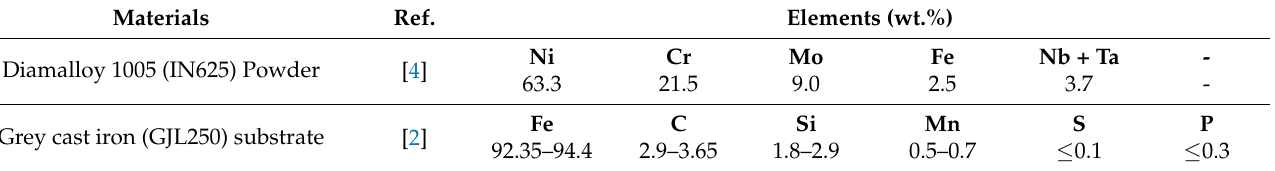
Table 2. Chemical compositions of the powder and substrate.